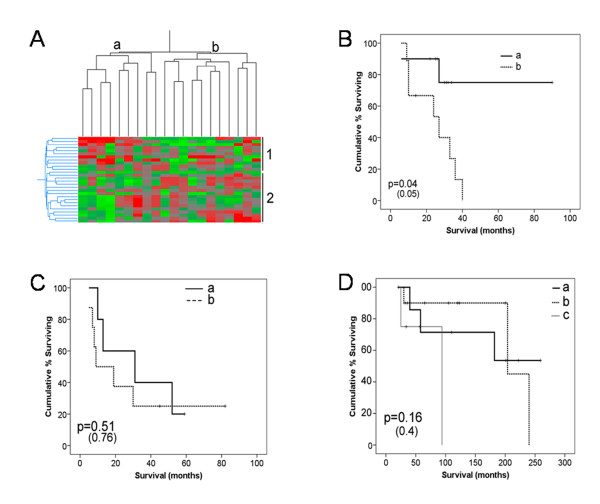
Supervised hierarchical clustering using the mSS signature highlights gene groups correlating with survival in peritoneal mesotheliomas. Clustering of mesothelioma samples is shown in (A). Group A tumours had higher expression of group 1 genes and lower expression of group 2 genes, corresponding to a potential pro-inflammatory phenotype. Gene groups are given in Table 3. (B-D) Kaplan-Meier survival analyses of tumour groups from mSS supervised hierarchical clustering. (B) Peritoneal mesotheliomas, (C) MPNST and (D) Liposarcoma. Only mesothelioma samples showed a significant association with survival improvement. P values shown in brackets are p-values after adjustment for age and sex. All survival analysis performed in SPSS (version 15).